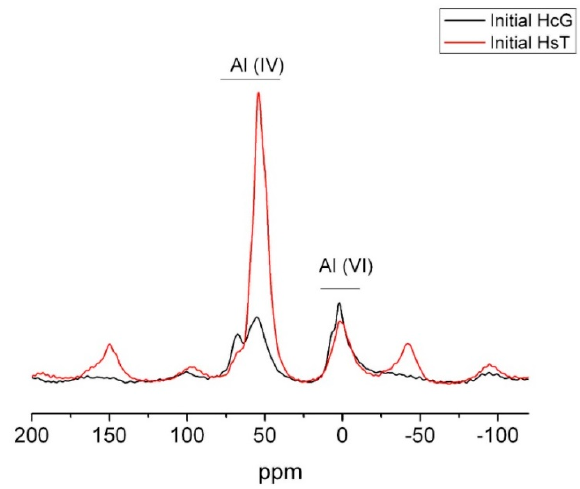
Figure 8. 27 Al NMR spectrum for initial wastes HsT and HcG.